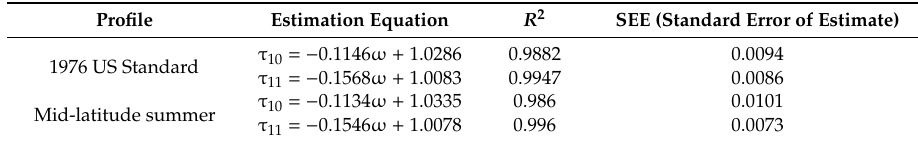
Table 5. Relationship between atmospheric transmittance and water vapor content in the column for the water vapor content range of 0.5-3 g · cm − 2